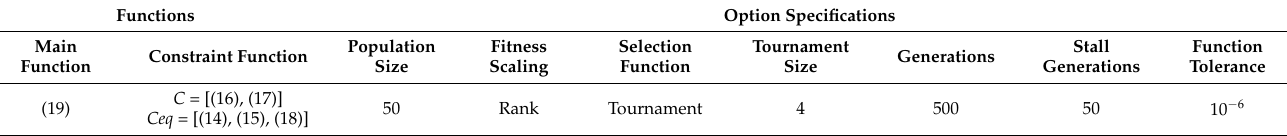
Table 2. The function parameters of the genetic